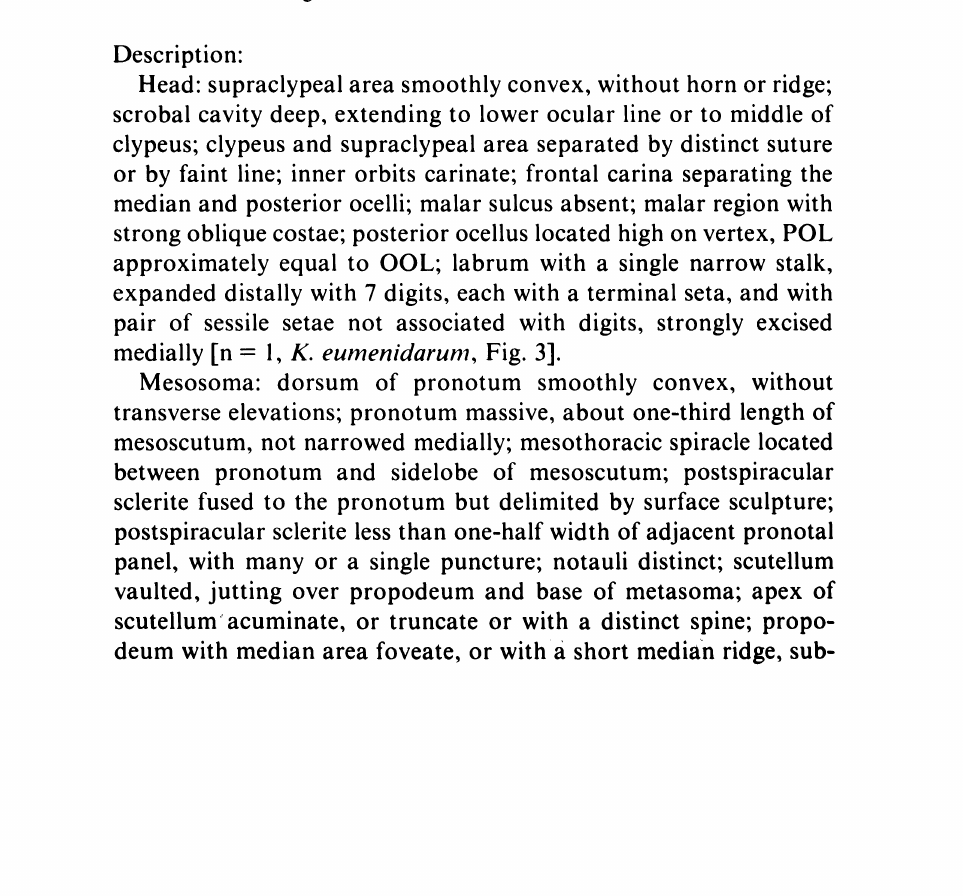
Fig. 1. Krombeinius saunion, lateral